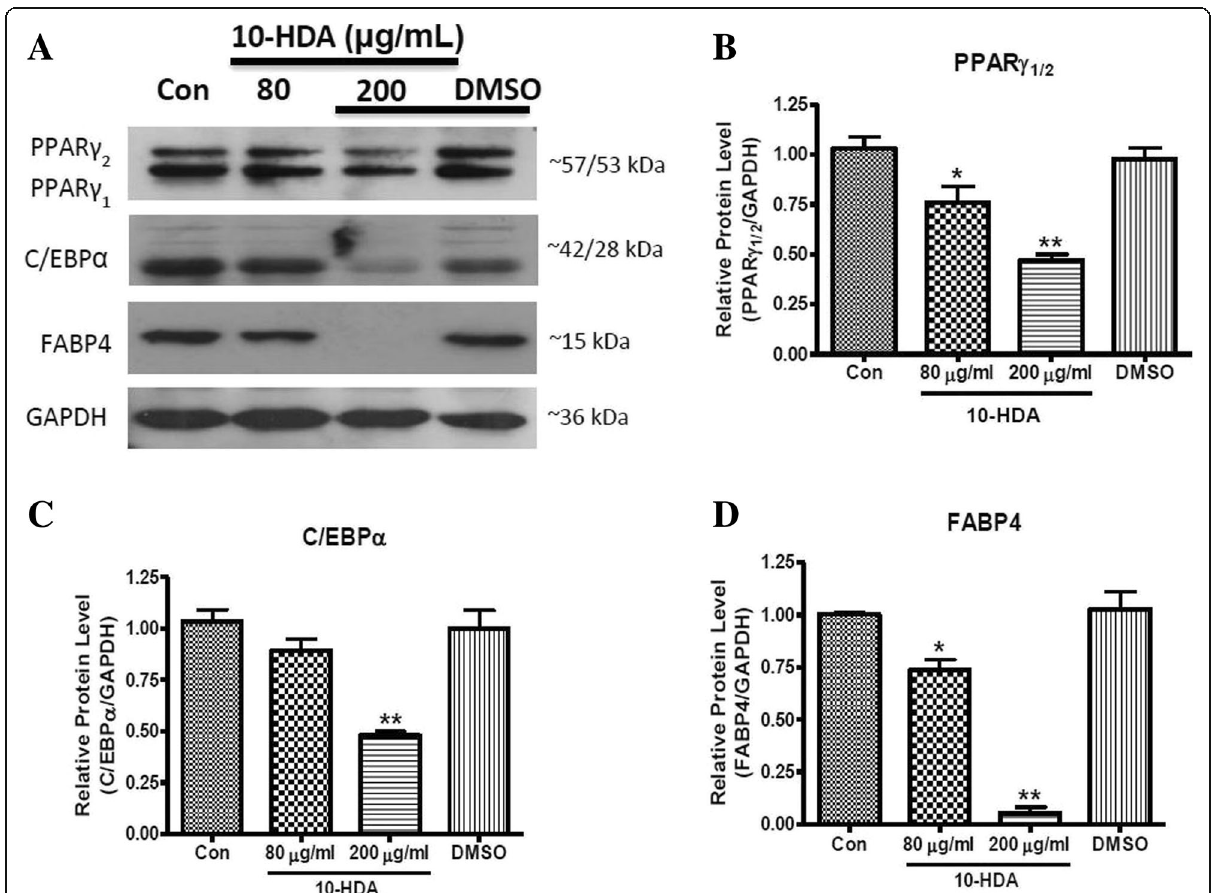
Fig. 4 Effects of 10-HDA on protein expression level of PPAR γ , C/EBP α , and FABP4 during 3 T3-L1 adipocyte differentiation. a The blot represented the protein expression levels of different transcription factors. The band intensities of ( b ) PPAR γ , ( c ) C/EBP α , and ( d ) FABP4 were measured and normalized to GAPDH. The data shown are presented as means ± SD of triplicate experiments. Statistical significance was calculated using one-way ANOVA followed by Dunnett ’ s multiple comparisons test. * P < 0.05 vs control; ** P < 0.01 vs